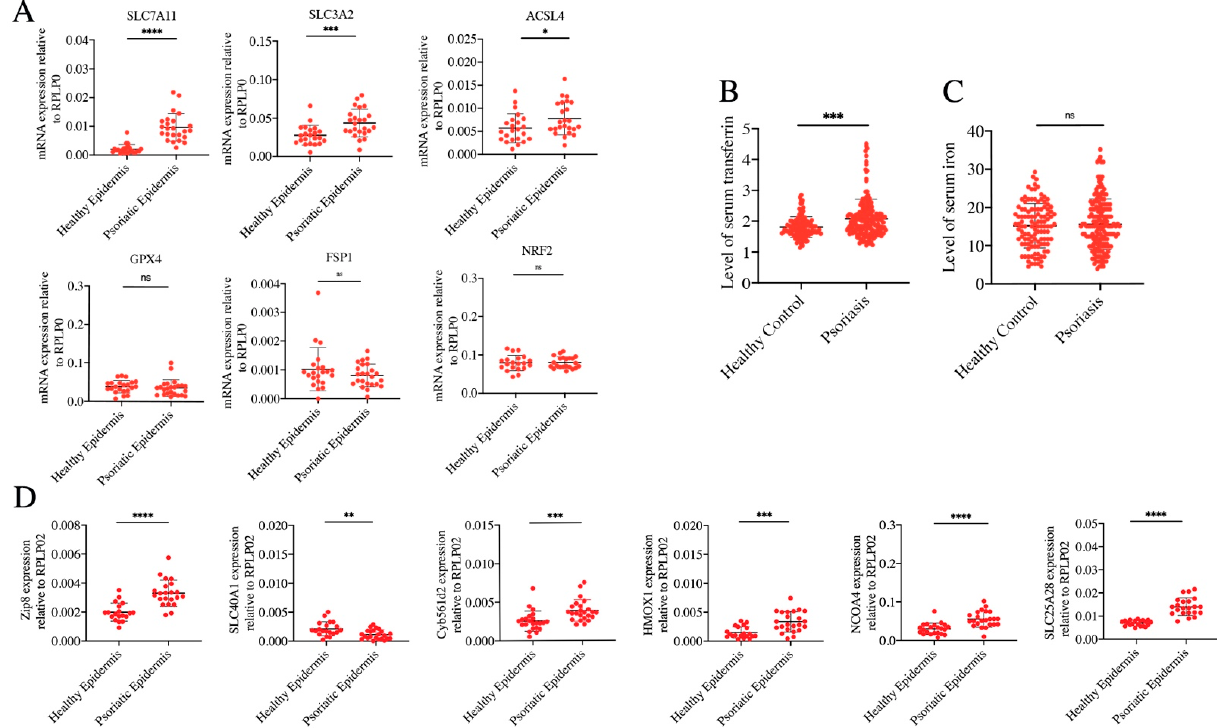
Figure 3. Stage of lipid peroxidation and iron metabolism in the epidermis of PV patients. ( A ) Lipid- peroxidation-related genes in the psoriatic epidermis ( n = 23) and normal controls ( n = 24). ( B , C ) Levels of serum iron and serum transferrin in psoriasis patients ( n = 177) and normal controls ( n = 115). ( D ) Iron-metabolism-related genes in the psoriatic epidermis ( n = 23) and normal controls ( n = 24). Data represent the mean ± SEM: ns p > 0.05, * p < 0.05, ** p < 0.01, *** p < 0.001, and **** p < 0.0001.